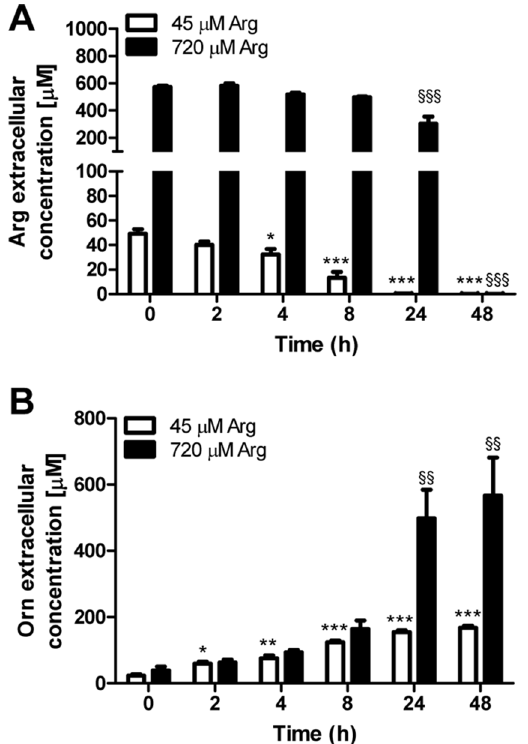
Figure 5. Time course of arginine metabolism in low and high arginine medium. Concentrations of arginine (A) and ornithine (B) were measured in the medium of mycoplasma-infected B 0 AT1-TMEM27 overexpressing MDCK cells treated with 45 m M (open bar) or 720 m M (black bar) arginine at the indicated times. Groups were compared by one-way ANOVA followed by Dunnett post-test; *** p # 0.001, ** p # 0.01, * p # 0.05 versus 45 m M arginine; 111 p # 0.001, 11 p # 0.01, versus 720 m M